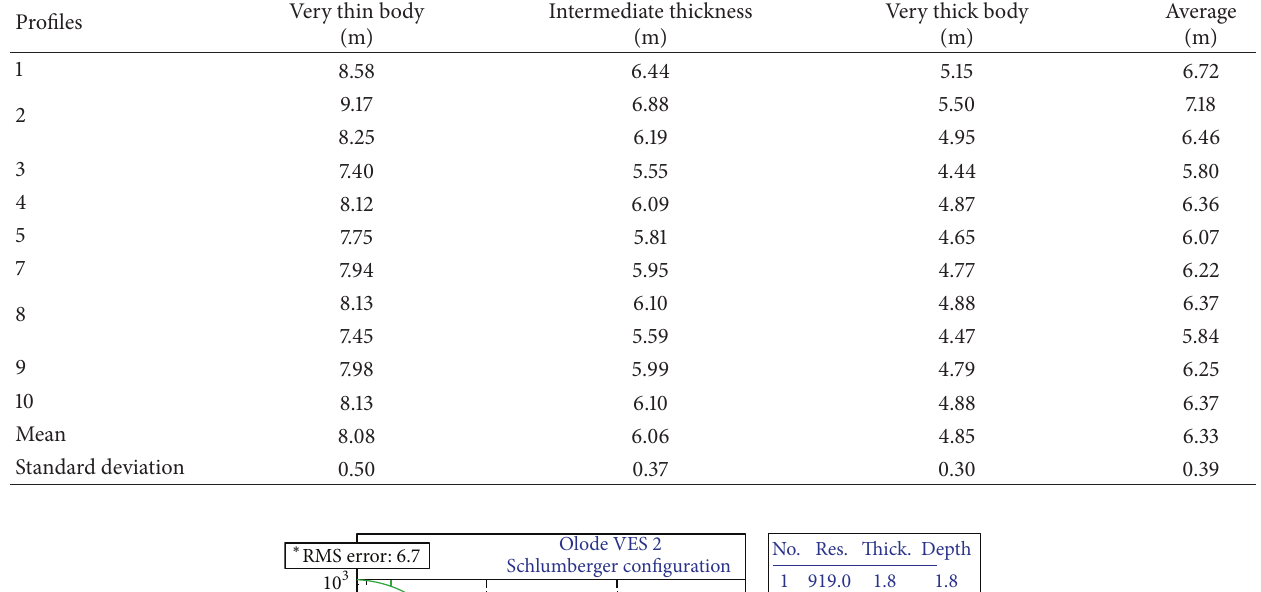
Table 2: Summary of depth estimates from the ground magnetic data.